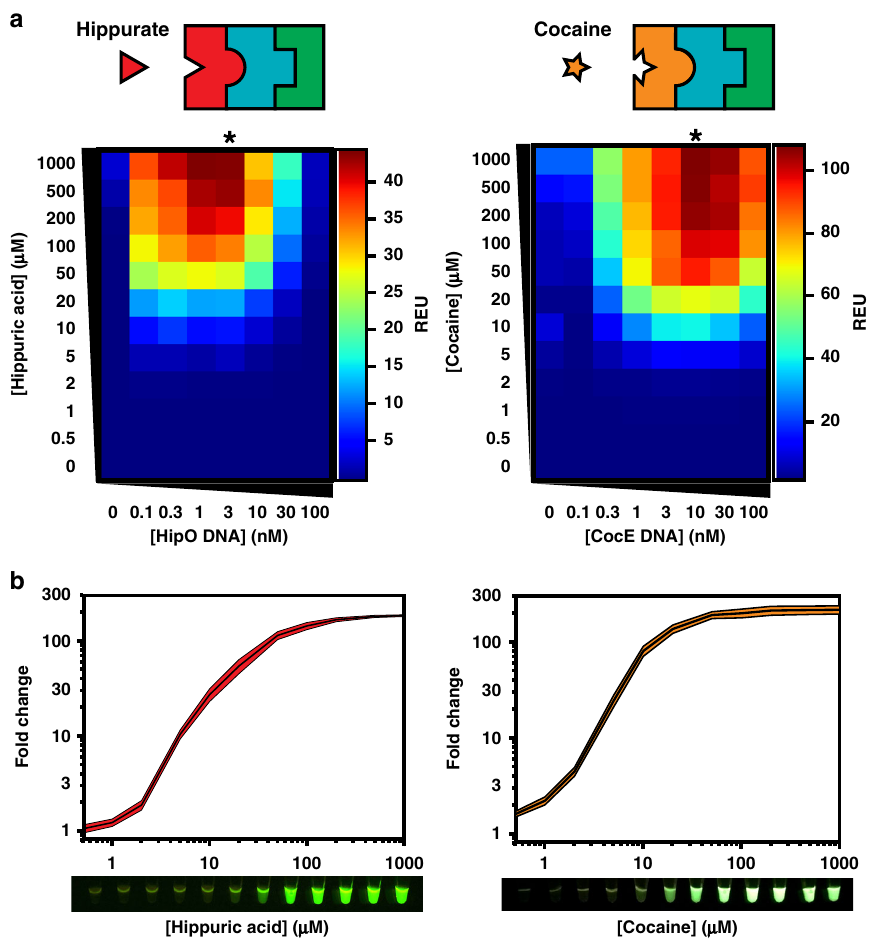
Fig. 3 Metabolic transducers expand the chemical detection space of cell-free biosensors. a Hippurate or cocaine can be detected using different metabolic transducers. Plasmids encoding the HipO or CocE enzymes, which convert hippuric acid or cocaine into benzoic acid, were mixed at different concentrations with optimal BenR and reporter plasmids concentrations as determined in Fig. 2 (30 nM and 100 nM, respectively). These reactions were then incubated with increasing concentrations of inducer for at least 8 h. The heat maps represent the signal intensity after four hours (Supplementary Figs. 6-7 and Supplementary Table 2). Asterisks denote the optimal DNA concentration for the metabolic module. Data are the average of three experiments performed on three different days and all fl uorescence values are expressed in Relative Expression Units (REU) compared with 100 pM of a strong, constitutive sfGFP-producing plasmid. b Optimized cell-free biosensors incorporating a metabolic transducer module exhibit comparable performance to the BenR sensor module (from Fig. 2c). All data are the mean of three experiments performed on three different days. Shaded area around curves corresponds to ±SEM of the three experiments. See Methods for more details. Lower panel: GFP expression in cell-free reactions in response to various concentrations of inducer visualized on a UV table. Source Data are available in the Source Data